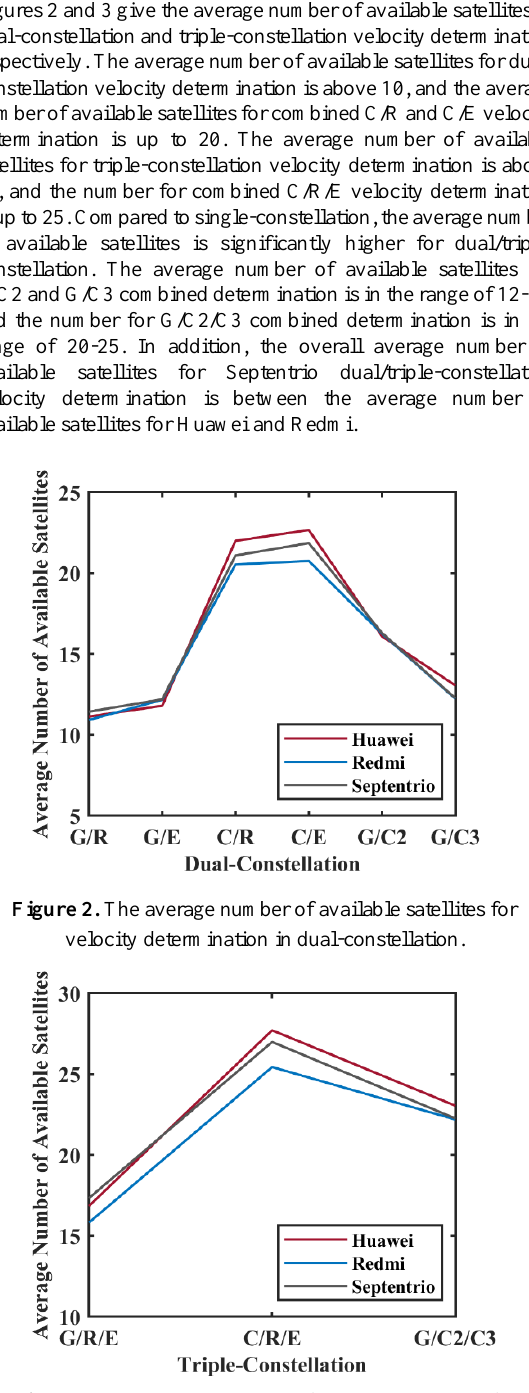
Figure 3. The average number of available satellites for velocity determination in